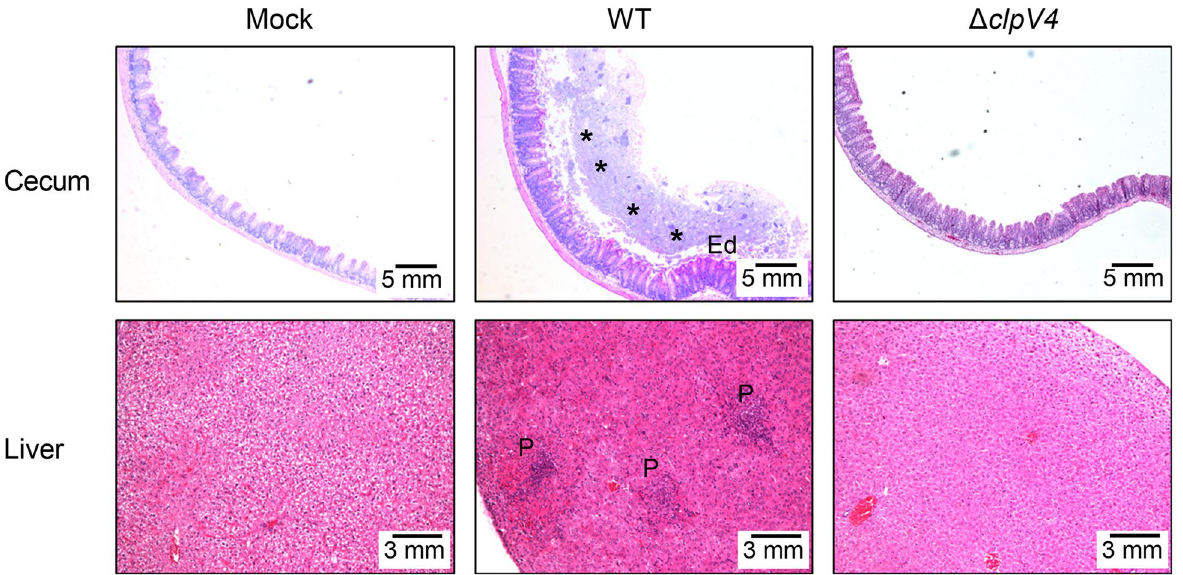
Fig. 6 Histopathological changes in the cecum and liver of infected mice. Hematoxylin-Eosin (H&E) staining of the cecum and liver of the C57BL/6 mice intragastrically inoculated with Y. pseudotuberculosis WT or Δ clpV4 mutant. Tissues were collected 48 h post infection. Pictures show representatives of multiple fields of sections from groups of 3–5 mice. Dashed halo (*), focal invasion of lymphocytes into the lamina propria; Ed: edema formation. P: piecemeal